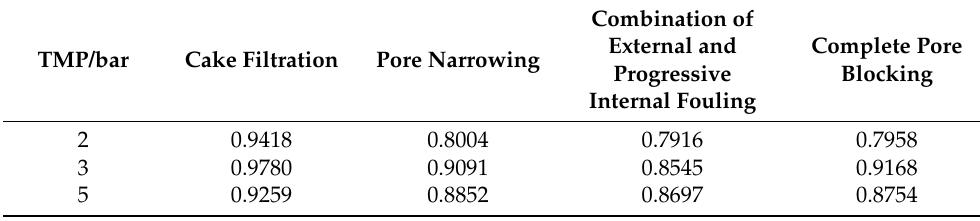
Table 6. R 2 values of regression by different TMPs for four fouling models.